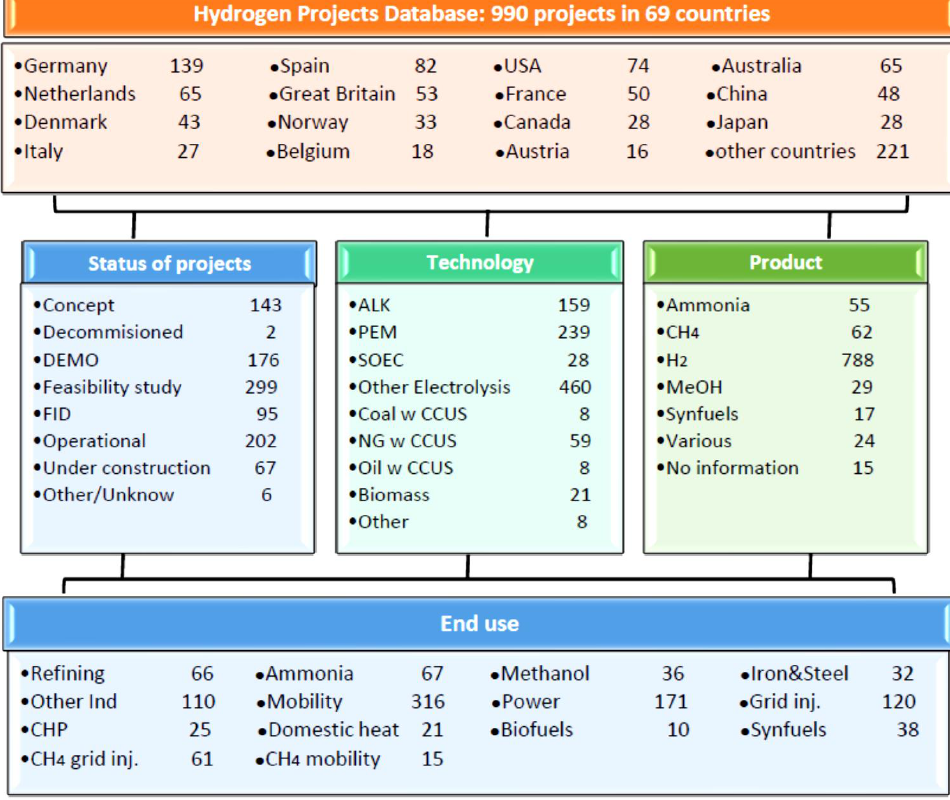
Figure 2. Characteristics of hydrogen projects declared and implemented in the world, compiled by source [31].